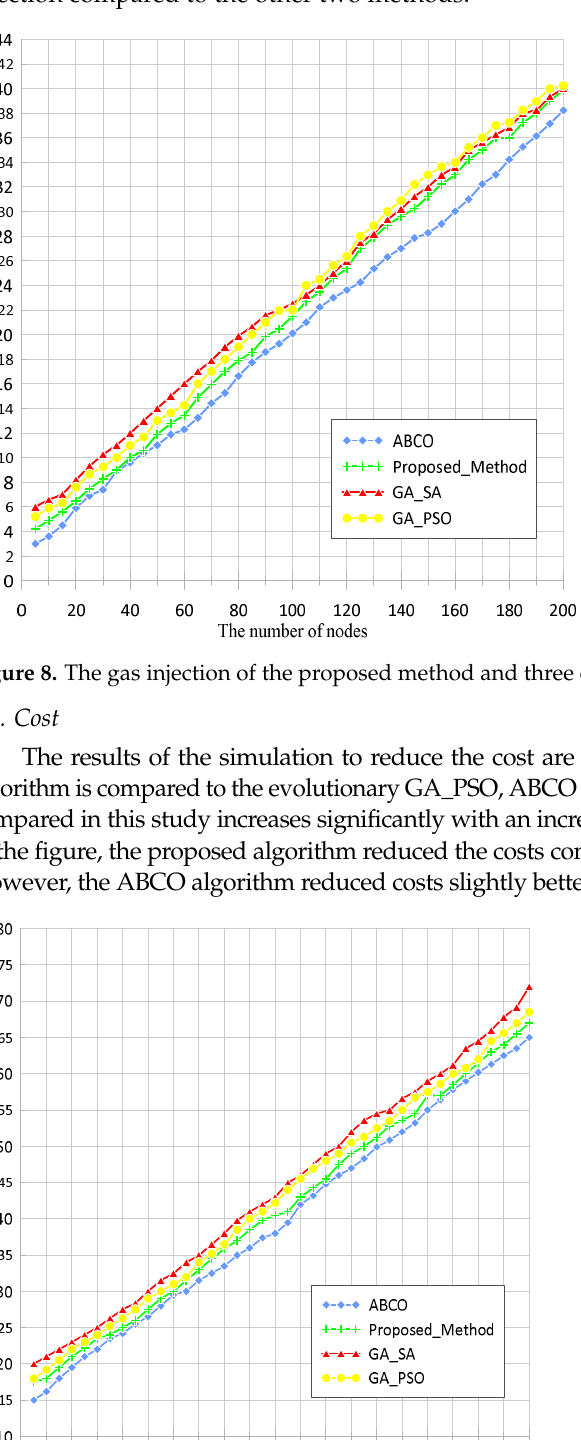
Figure 9. The cost of the proposed method and three evolutionary algorithms.